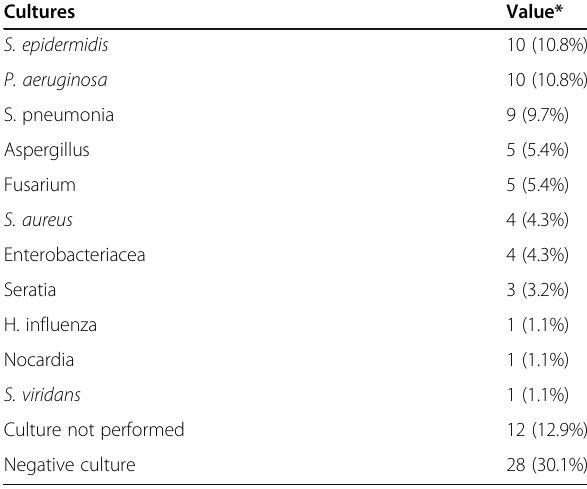
Table 1 Descriptive data of pediatric patients with keratitis. OD: Oculus Dexter, OS: Oculus Sinister, OU: Oculus Uterque